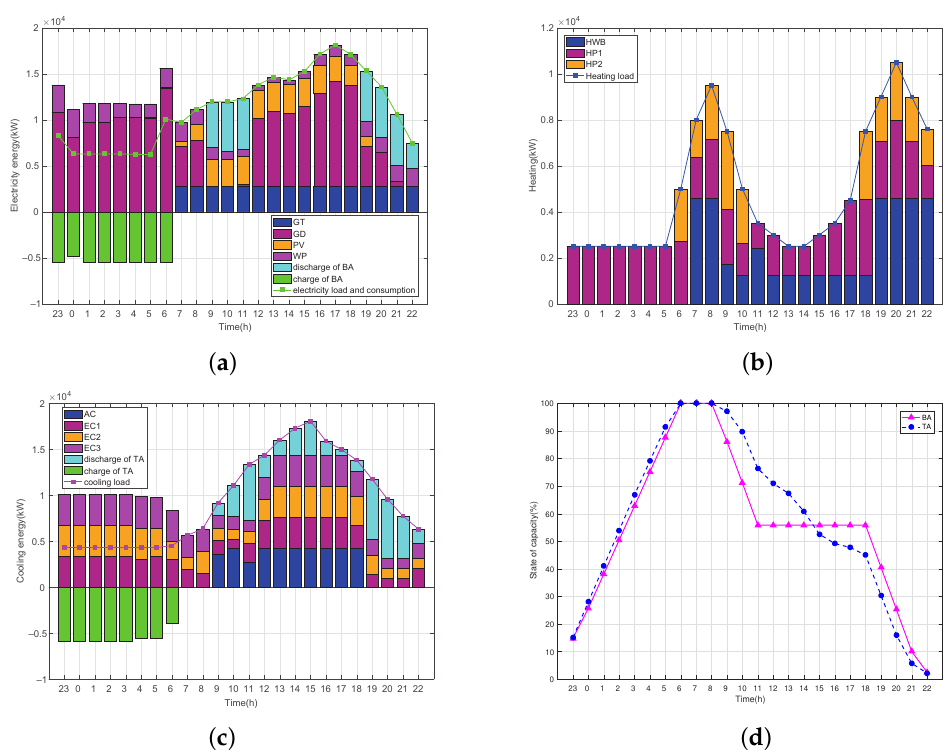
Figure 8. The optimal generation scheduling results in Case 2 from the perspective of energy analysis. ( a ) the electrical power allocation among multiple devices; ( b ) the heating energy allocation among multiple devices; ( c ) the cooling energy allocation among multiple devices; and ( d ) the curves of the energy stored in the TA and